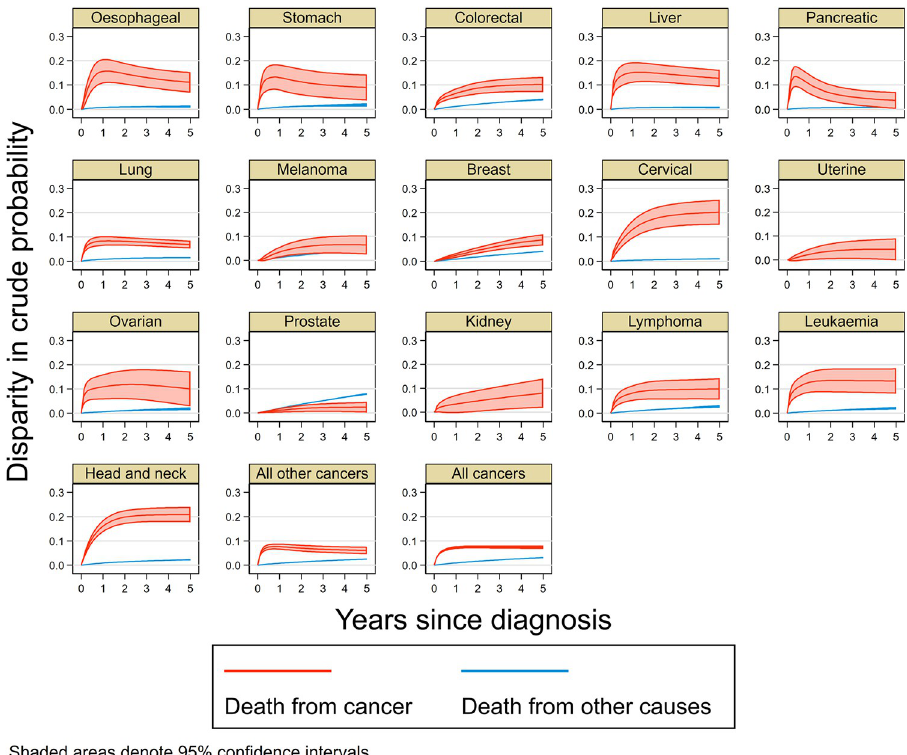
Fig 3. Disparity in standardised crude probability of death from cancer (a) and other causes (b), five years since diagnosis between Aboriginal and Torres Strait Islanders and other Australians, by cancer type, Australia, 2005–2016.